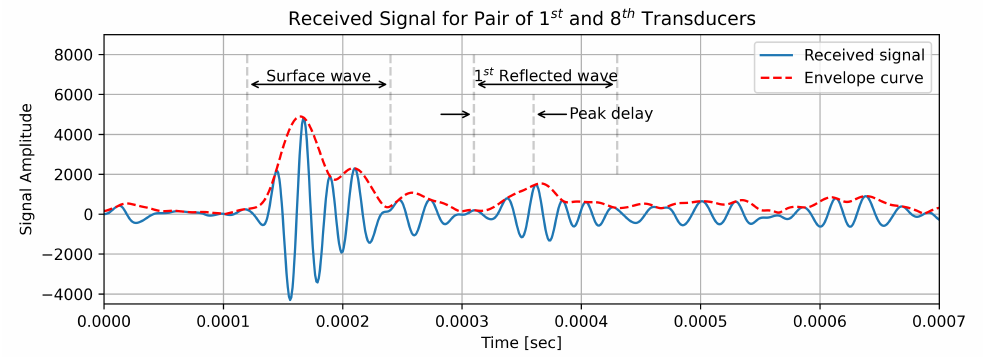
Figure 10. Received Signal by A1040 MIRA for Pair of 1st and 8th